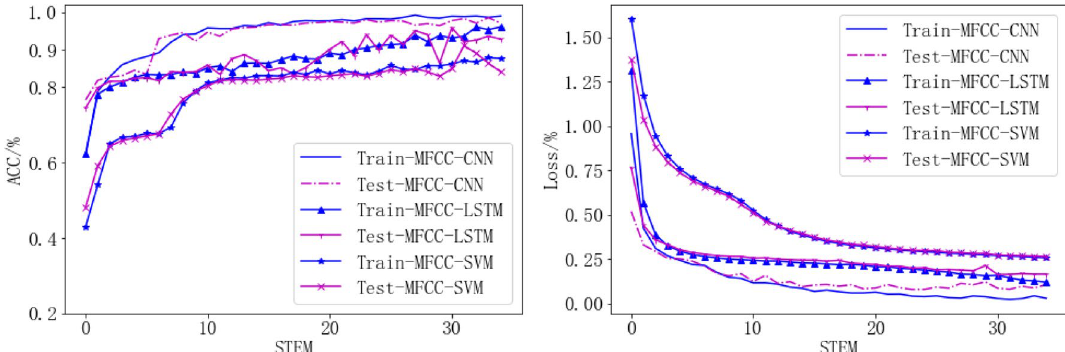
Fig. 7 Accuracy and Loss of each model in dataset MFCC